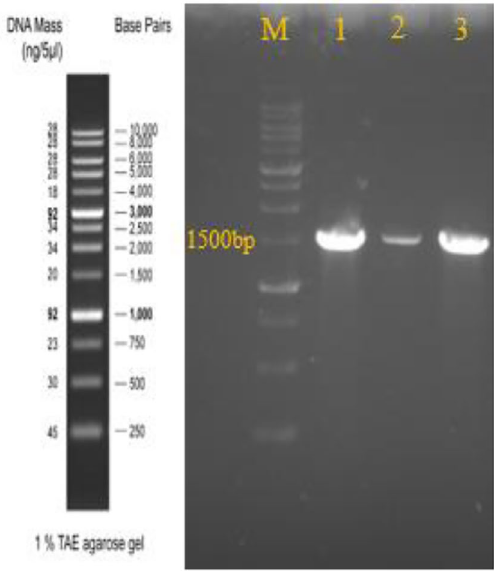
Figure 2. PCR products of 16SrRNA from Bacillus isolates. M: 1 Kb DNA ladder. Lane 1: Positive control. Lane 2 and 3: CM1 and CM2 strains.